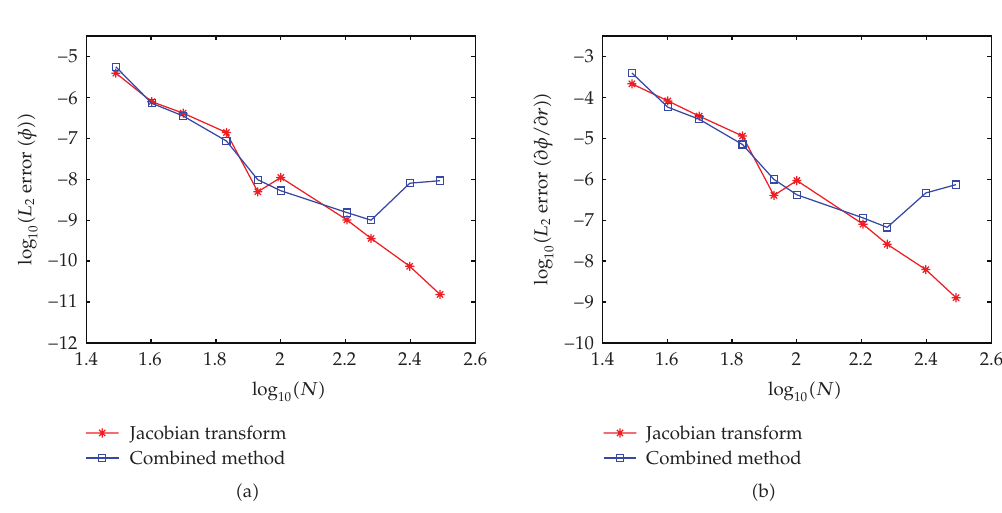
Figure 10: Comparisons of convergence rates of the sixth-order compact schemes for the sample geodynamo problem. Results were obtained separately from the Jacobian transformation and the combined method at L (cid:9) 28: solution error φ (cid:6) a (cid:7) ; derivative error ∂φ/∂r (cid:6) b (cid:7)